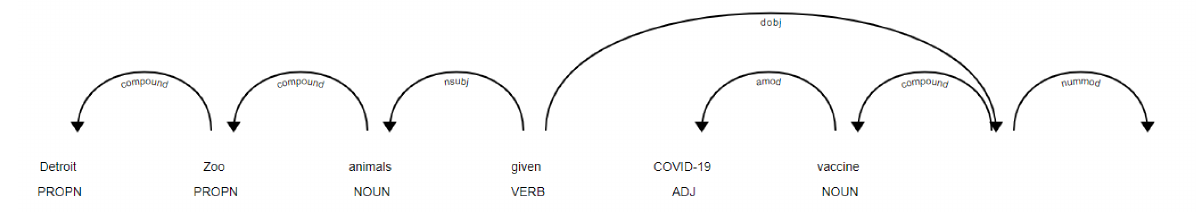
Figure 12. Most followed user’s tweet (positive).The time period stands between 29 August 2021 and 31 August